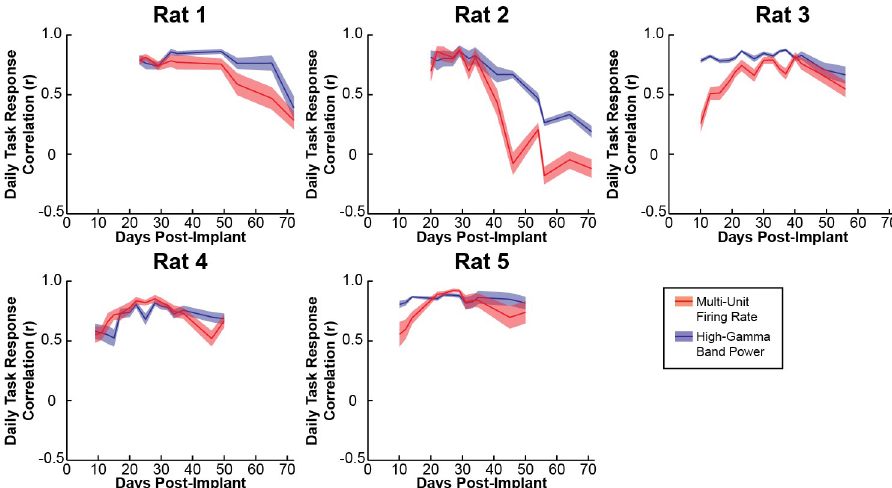
Fig 9. Cross-day stability. The stability of task-related changes in neural activity during the pellet retrieval was examined by determining the correlation between the daily mean firing rate and the overall mean firing rate as well as the correlation between the daily high-gamma band power change and the overall mean high-gamma band power change for each channel. Plots show the mean daily correlation across channels for the pellet retrieval and the error bars show the standard error. While a decrease in signal quality was observed at 9 weeks and 5 weeks in rats 1 and 2 respectively, overall, task-related changes in multi-unit activity and high-gamma band power were stable across days for each rat. While changes in multi-unit firing rate and high-gamma band power were both stable across recording days, the task-related the high-gamma band power change had higher correlations between the daily and overall mean than was observed for task-related multi-unit firing rate changes. Additionally, high-gamma band power changes show a slower decrease in stability from the degradation in signal quality observed in rats 1 and 2.